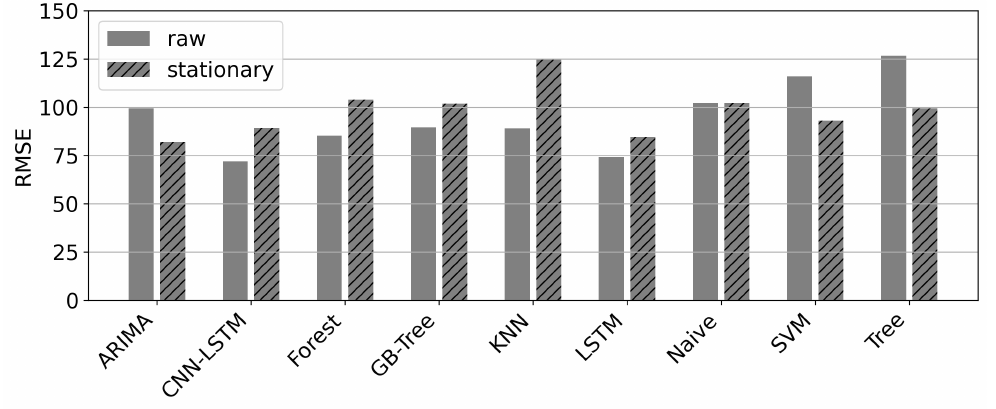
Figure 6. Average RMSE over the utilized data set.